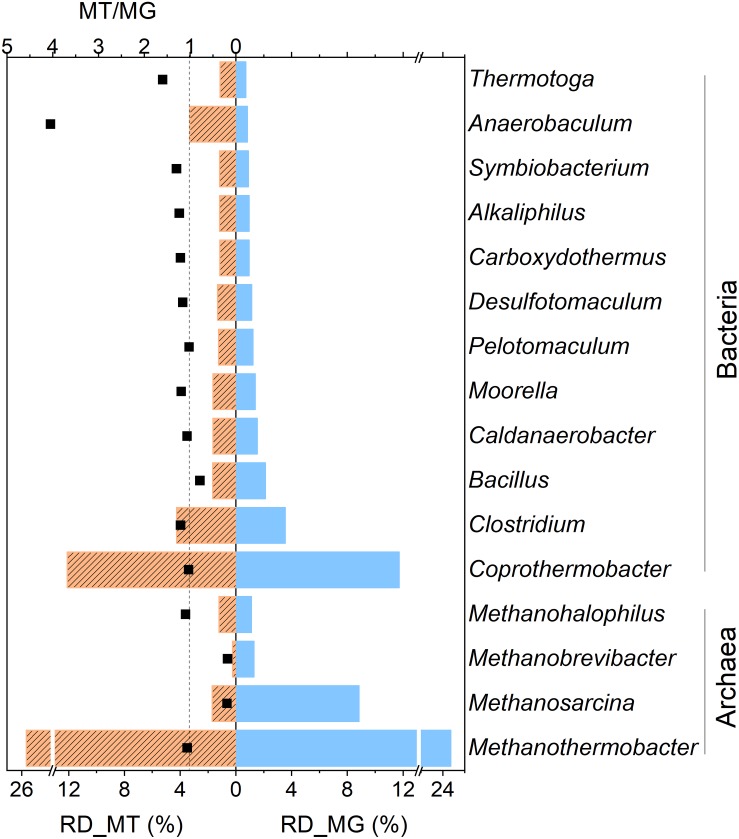
Relative abundance levels of the dominant genera of the metagenome (RD_MG, blue column) and metatranscriptome (RD_MT, orange column) of the RD_5.5 reactor. Only the relative abundance values of the identified genera higher than 1% in DNA or the cDNA library are listed. The black dots (MT/MG) indicate the ratio of the relative abundance values of those taxa from the metatranscriptome and metagenome. The dashed line indicates that the value of MT/MG is 1.